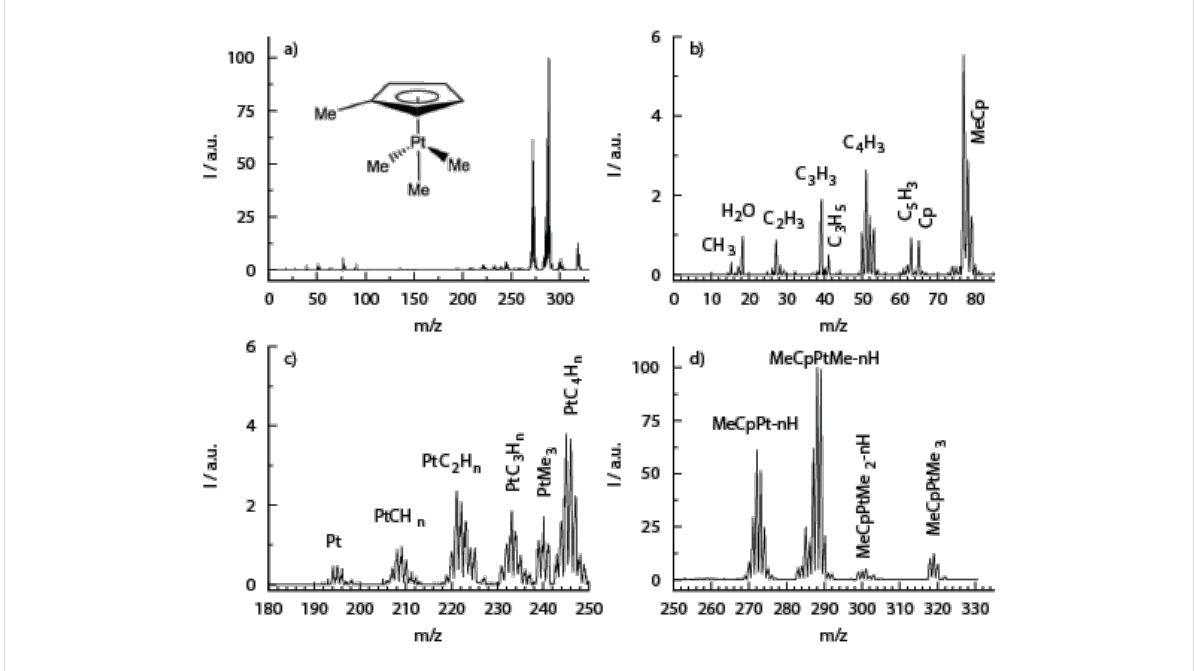
Figure 8: Positive ion mass spectrum of MeCpPtMe 3 recorded with electron energy of 100 eV (reproduced with permission from [15], Copyright (2012) Royal Society of Chemistry); (a) overview of the full mass range ( m / z 0–330), (b), (c) and (d); expanded portion of the spectrum for m / z 0–85, m / z 180–250 and m / z 250–330,